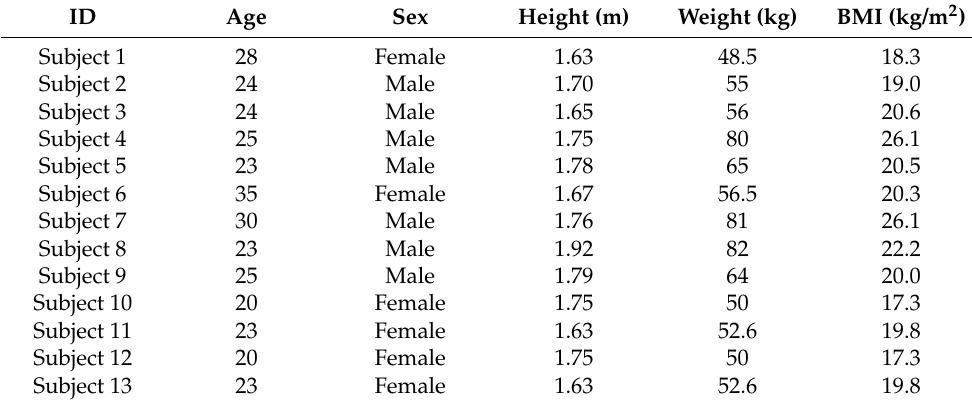
Table 1. Participant details recruited for this